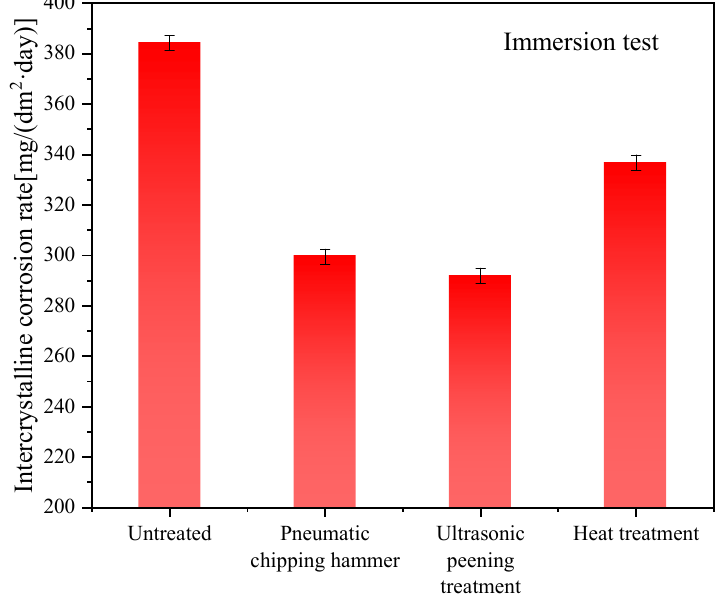
Figure 11. Intergranular corrosion rates of welded joints with different treatments.